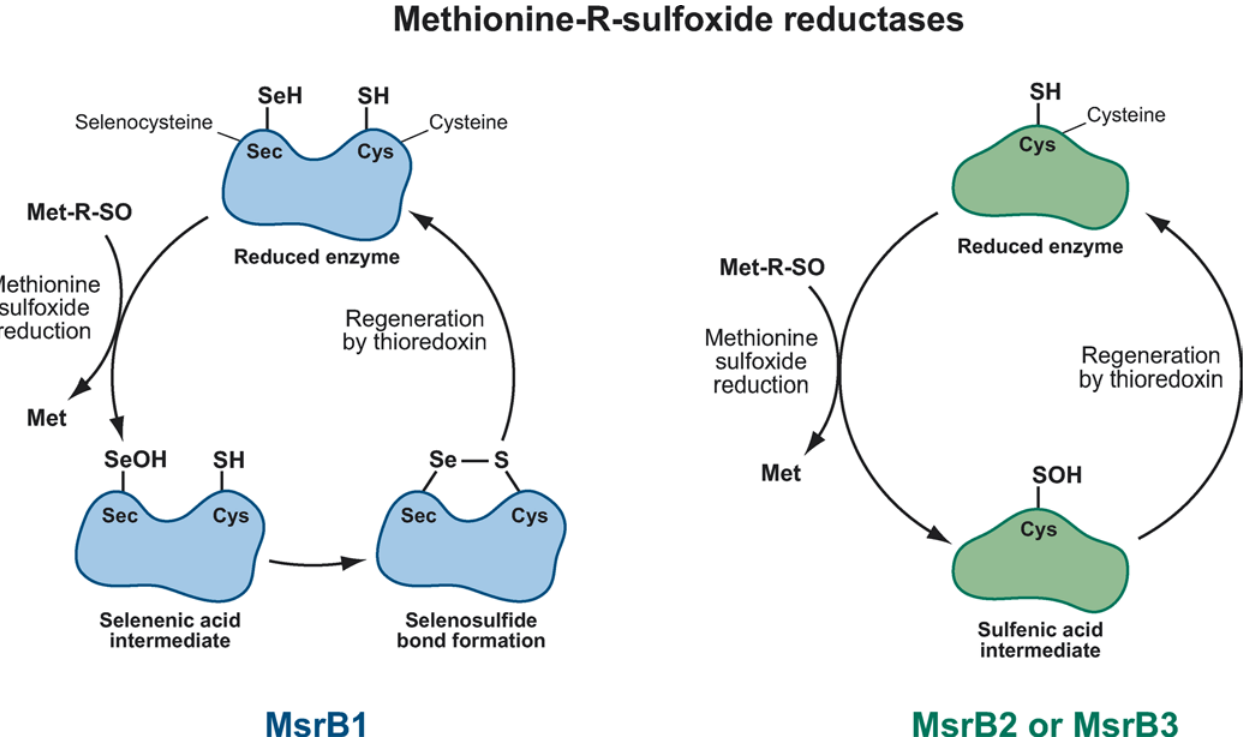
Figure 1. Schematic Illustrations Comparing the Enzymatic Reactions of Three Mammalian MsrBs MsrB1 is a selenium-containing protein, whereas MsrB2 and MsrB3 contain cysteine in the active site. (Illustration: Rusty Howson, sososo